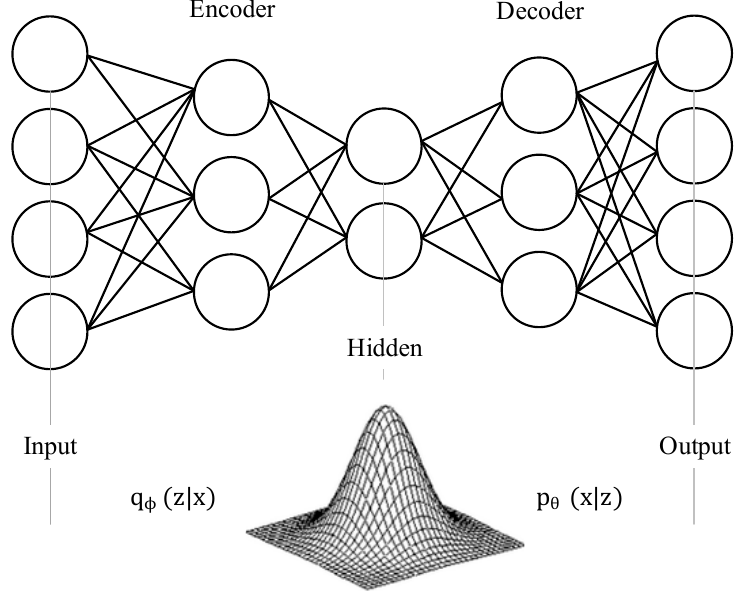
Figure 3. Variational autoencoder.